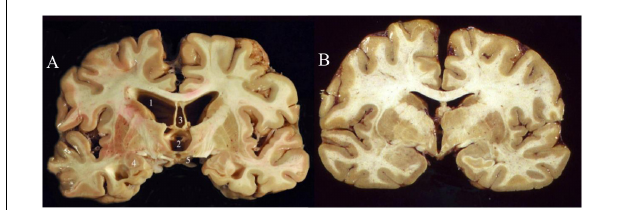
FIGURE 1 | Coronal slices of advanced CTE (A) compared to a normal brain (B) . CTE brain shows enlargement of the ventricles (1–2), septum pellucidum (3), medial temporal lobe (4), and mammillary bodies (5) (Stern et al., 2011). Permission obtained from John Wiley and Sons through PM&R